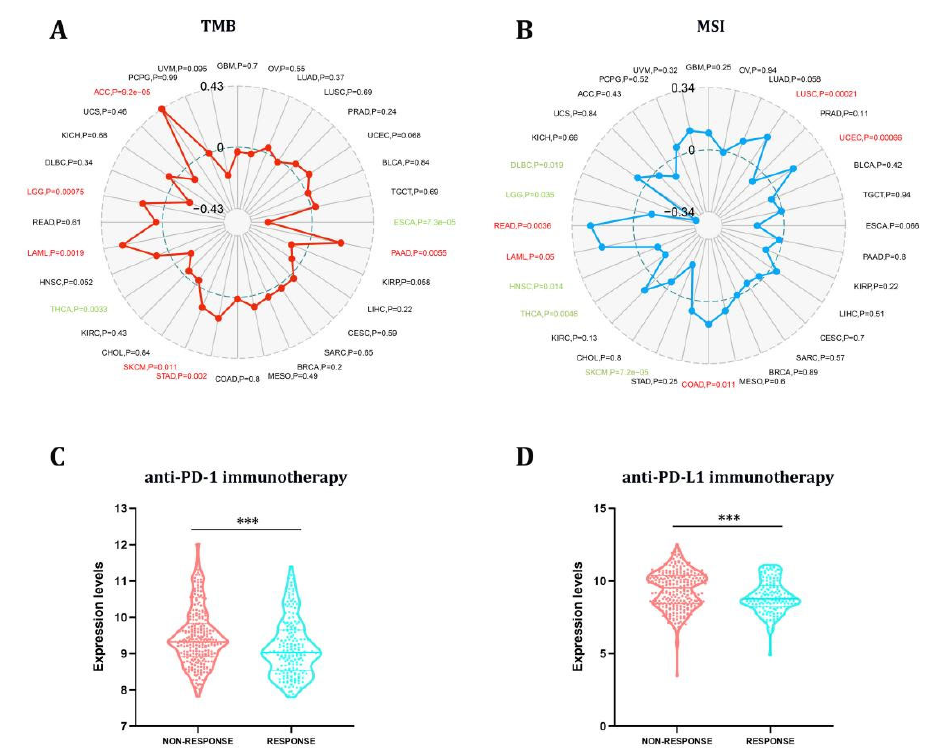
Figure 5. The STX6 expression level can predict the effect of immunotherapy. STX6 expression was favorably connected with TBM in ACC, LGG, LAML, SKCM, STAD, and PAAD while being negatively correlated in THCA and ESCA ( A ). Additionally, STX6 showed a favorable link with READ, LAML, COAD, LUSC, and UCEC, but a negative relationship with the MSI of five different cancers, including DLBC, LGG, HNSC, THCA, and SKCM ( B ). For immunotherapy, STX6 mRNA expression was higher in the non-response group than in the response group independent of treatment with PD-L1 or PD-1 by integrating GEO transcriptome sequencing data on PD-1 and PD-L1 treatment ( C , D ). *** p < 0.001.